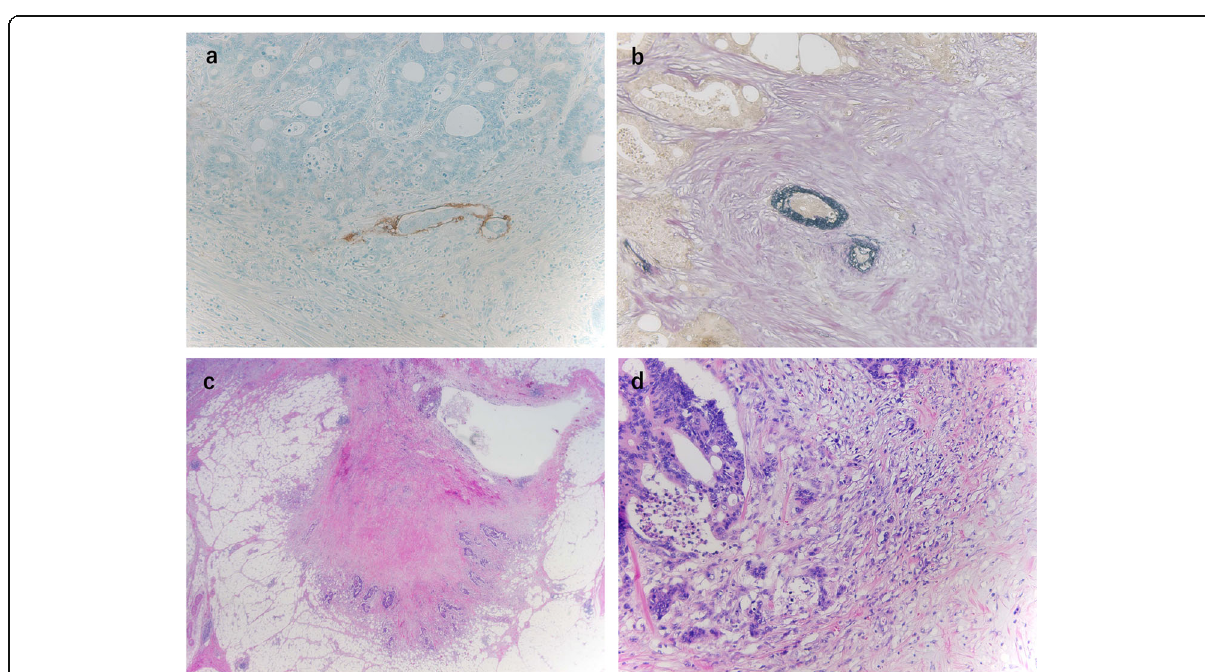
Fig. 4 Histopathological findings. a Cancer cells are observed in the lymphatic vessels (×10) (D2-40). b Cancer cells are observed in the venous duct (×10) (EVG). c Extramural tumor deposits without lymph node structure are seen in the extramural adipose tissue (×20) (hematoxylin and eosin). d Tumor budding grade 2 is seen in the leading edge of the cancer cells (×2) (hematoxylin and